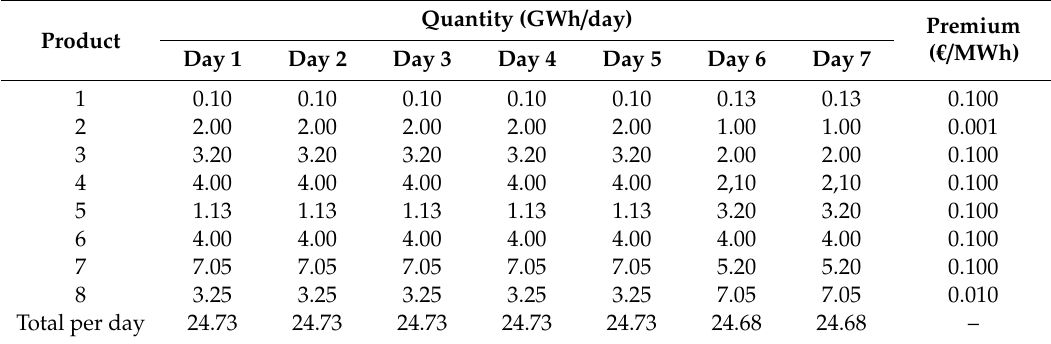
Table 13. Open access capacity market—quantity by products, and auction premium.